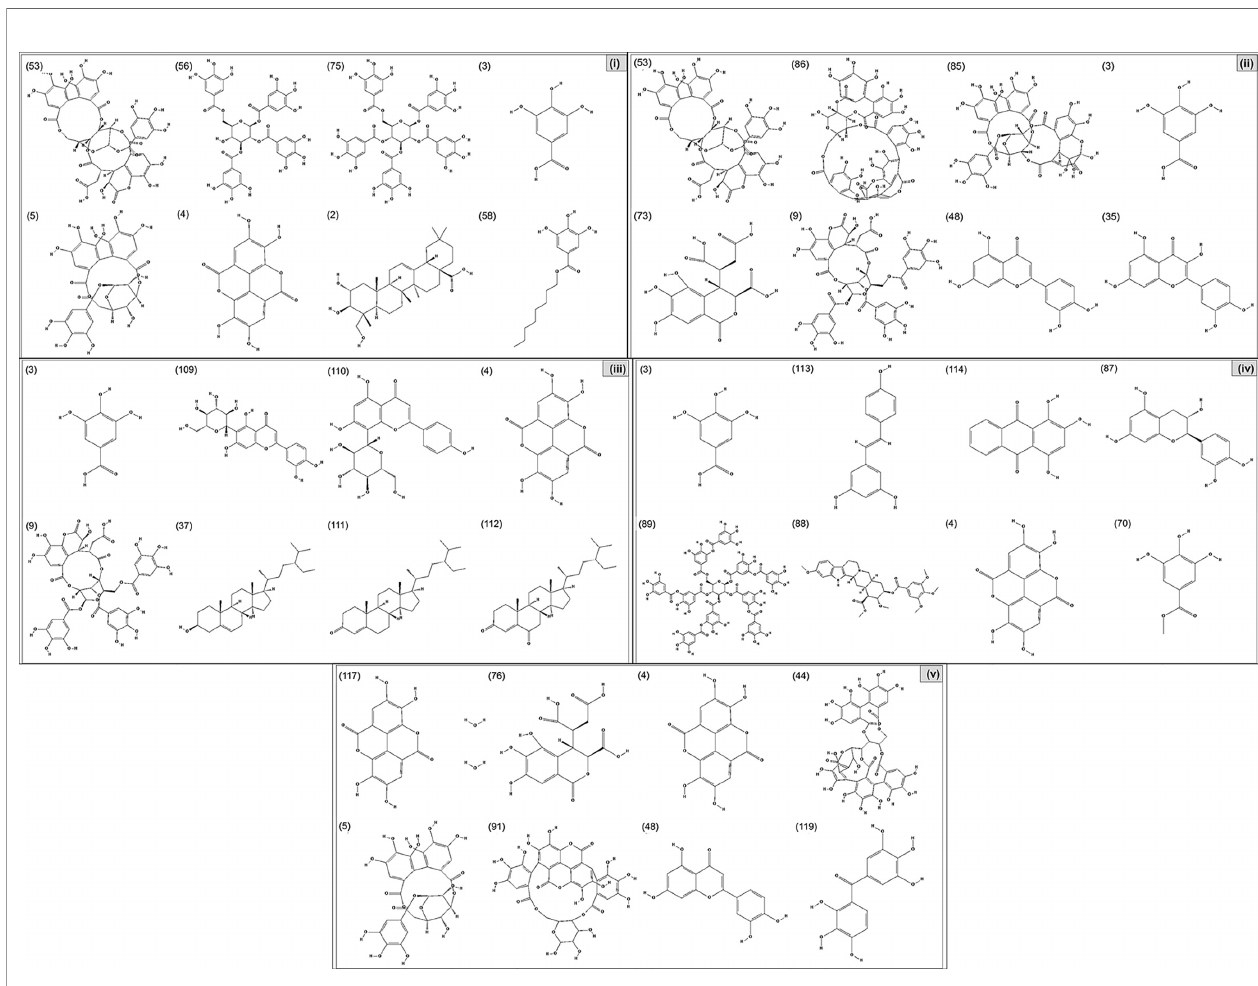
FIGURE 4 | (i) Compounds from Terminalia species that have been studied for their antidiabetic and antiobesity properties. (53) Chebulagic acid, (56) 1,2,3,6-tetra- O-galloyl- b -D-glucose, (75) 1,2,3,4,6-penta-O-galloyl-beta-D-glucopyranose, (3) gallic acid, (5) corilagin, (4) ellagic acid, (2) arjunolic acid, (58) octyl gallate. Images from the National Center for Biotechnology Information, 2019a; National Center for Biotechnology Information, 2019c; National Center for Biotechnology Information, 2019g; National Center for Biotechnology Information, 2019i; National Center for Biotechnology Information, 2019k; National Center for Biotechnology Information, 2019m; National Center for Biotechnology Information, 2019r; National Center for Biotechnology Information, 2019s; (ii) Compounds from Terminalia species that have been studied for their antiproliferative properties. (53) Chebulagic acid, (86) punicalagin, (85) geraniin, (3) gallic acid, (73) chebulic acid, (9) chebulinic acid, (48) luteolin, (35) quercetin. Images from the National Center for Biotechnology Information, 2019c; National Center for Biotechnology Information, 2019d; National Center for Biotechnology Information, 2019f; National Center for Biotechnology Information, 2019h; National Center for Biotechnology Information, 2019m; National Center for Biotechnology Information, 2019n; National Center for Biotechnology Information, 2019p; National Center for Biotechnology Information, 2019v; (iii) Compounds from Terminalia species that have been studied for their antiin fl ammatory properties. (3) Gallic acid, (109) luteolin-6-C-glucoside, (110) vitexin, (4) ellagic acid, (9) chebulinic acid, (37) b -sitosterol, (111) b -sitostenone, and (112) stigmast-4-ene-3,6-dione. Images adapted from National Center for Biotechnology Information, 2019aa; National Center for Biotechnology Information, 2019ad; National Center for Biotechnology Information, 2019b; National Center for Biotechnology Information, 2019f; National Center for Biotechnology Information, 2019k; National Center for Biotechnology Information, 2019m; National Center for Biotechnology Information, 2019o; National Center for Biotechnology Information, 2019z; (iv) Compounds from Terminalia species that have been studied for their antioxidant properties. (3) gallic acid, (113) resveratrol, (114) purpurin, (87) catechin, (89) tannic acid, (88) reserpine, (4) ellagic acid, (70) methyl gallate. Images adapted from National Center for Biotechnology Information, 2019ab; National Center for Biotechnology Information, 2019e; National Center for Biotechnology Information, 2019k; National Center for Biotechnology Information, 2019m; National Center for Biotechnology Information, 2019q; National Center for Biotechnology Information, 2019u; National Center for Biotechnology Information, 2019w; National Center for Biotechnology Information, 2019x; National Center for Biotechnology Information, 2019y; (v) Compounds from Terminalia species that have been studied for their antimicrobial properties. (117) ellagic acid dihydrate, (76) chebulic acid, (4) ellagic acid, (44) castalagin, (5) corilagin, (91) punicalin, (48) luteolin, (119) exifone. Images adapted from National Center for Biotechnology Information, 2019ac; National Center for Biotechnology Information, 2019d; National Center for Biotechnology Information, 2019i; National Center for Biotechnology Information, 2019j; National Center for Biotechnology Information, 2019k; National Center for Biotechnology Information, 2019l; National Center for Biotechnology Information, 2019p; National Center for Biotechnology Information,